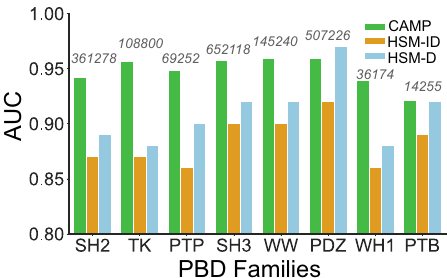
Fig. 5 Model performance of CAMP, HSM-ID, and HSM-D across eight families. CAMP achieved a relatively stable performance overall families, whereas the performances of HSM models were easily in fl uenced by the sample size (marked in gray number) of the training set. CAMP outperformed the HSM models, with an increase of AUC by 3 – 7%. All the evaluation metrics of the HSM models were obtained from the origin paper 10